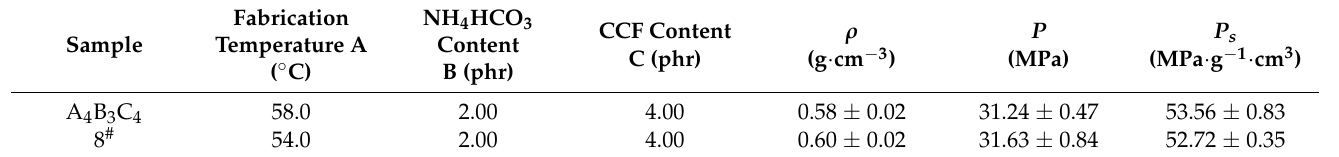
Table 6. The verification experiment of A 4 B 3 C 4 sample and parameters comparison.